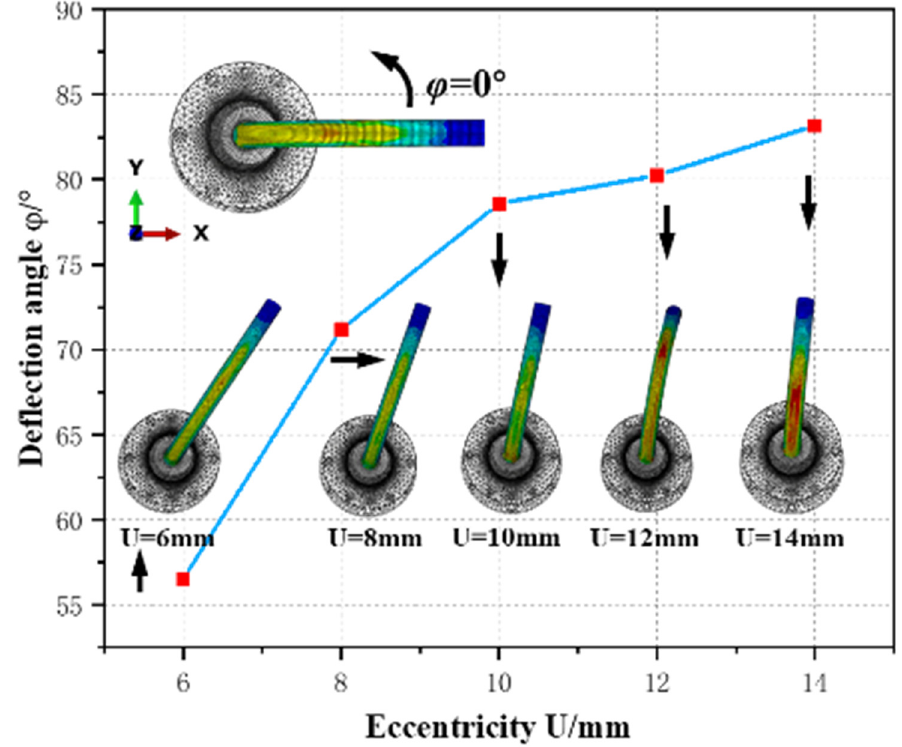
Figure 10. Simulation results of active deflection based on different eccentricities.